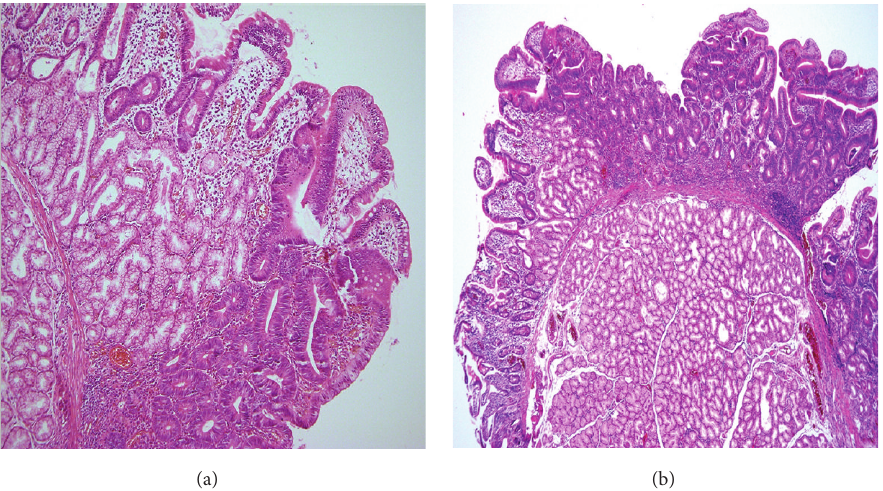
Figure 2: (a) Histological examination of lesions showed structures of the tubular or tubulovillous adenoma with mildly to moderately dysplastic epithelium and numerous Paneth cells. (b) Flat character of adenoma with central depression.